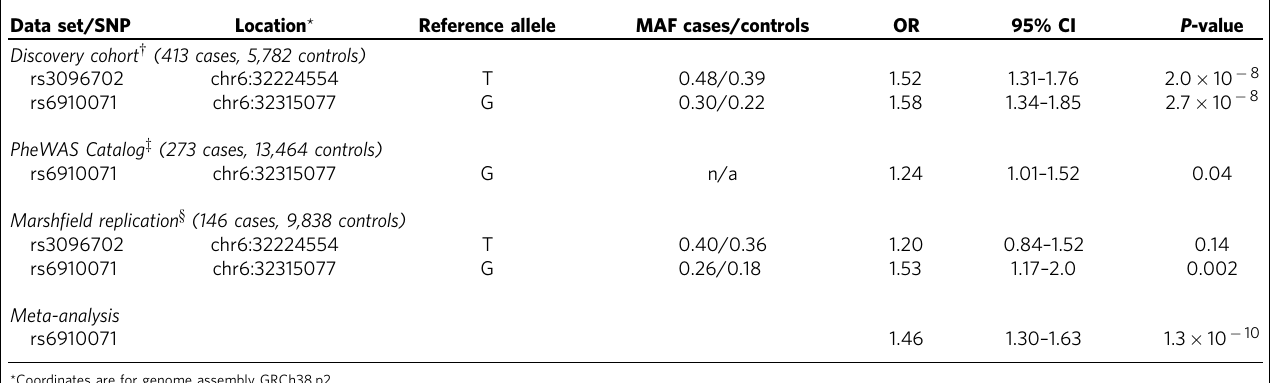
Table 3 | Significant SNP associations and replication of HLA-associated SNPs for polymyalgia rheumatica. Data set/SNP